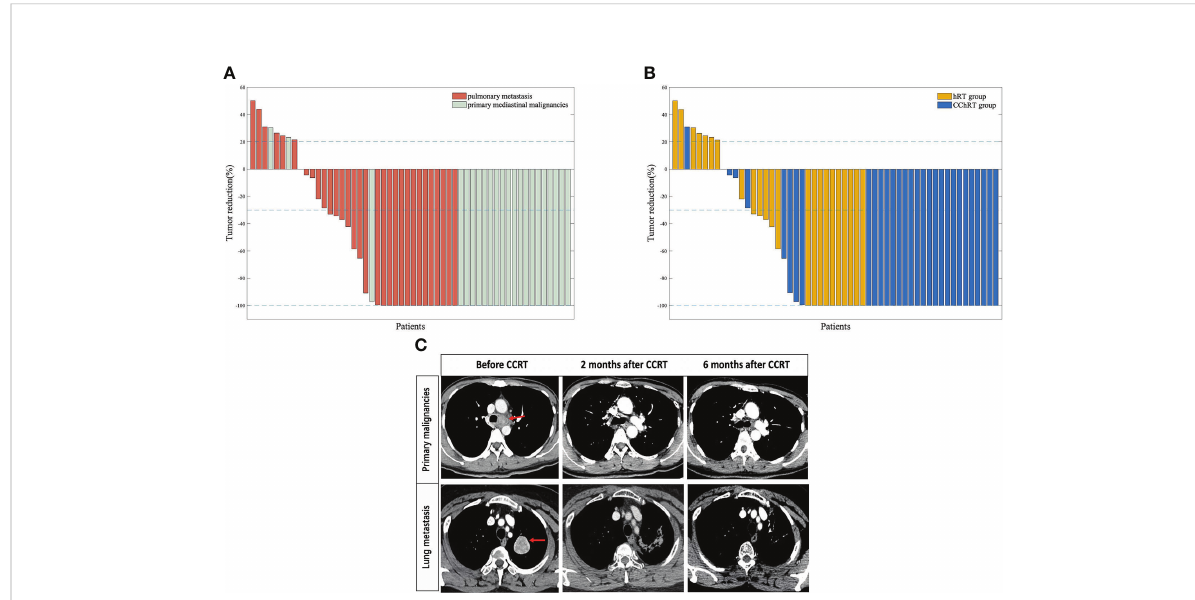
FIGURE 1 (A) Percentage change in tumor size at fi rst follow-up (based on baseline assessment) in patients with oligometastatic pulmonary lesions (n=31) and primary mediastinal malignancies (n=23) (B) Percentage change in tumor size at fi rst follow-up (based on baseline assessment) in